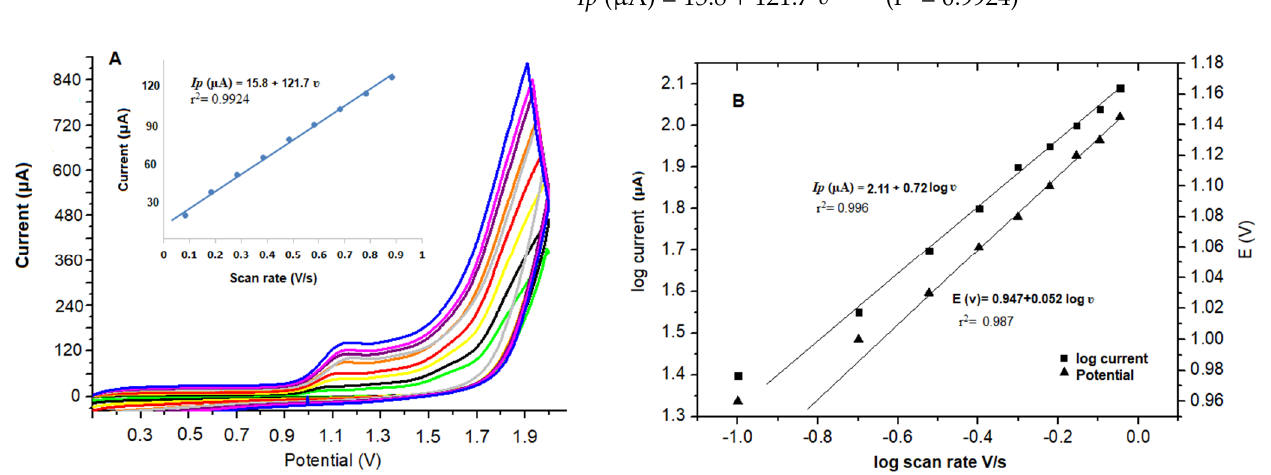
Figure 3. ( A ) The effect of different scan rates from 0.1 to 0.9 V s − 1 on CVs curves of FAV (70 × 10 − 9 mol L − 1 ), Inset: Scan rate calibration plot and ( B ) Dependence of logarithm peak current ( Ip /µA) and the oxidation peak potential ( E /V) on the logarithm of scan rate (log ν /Vs − 1 ).